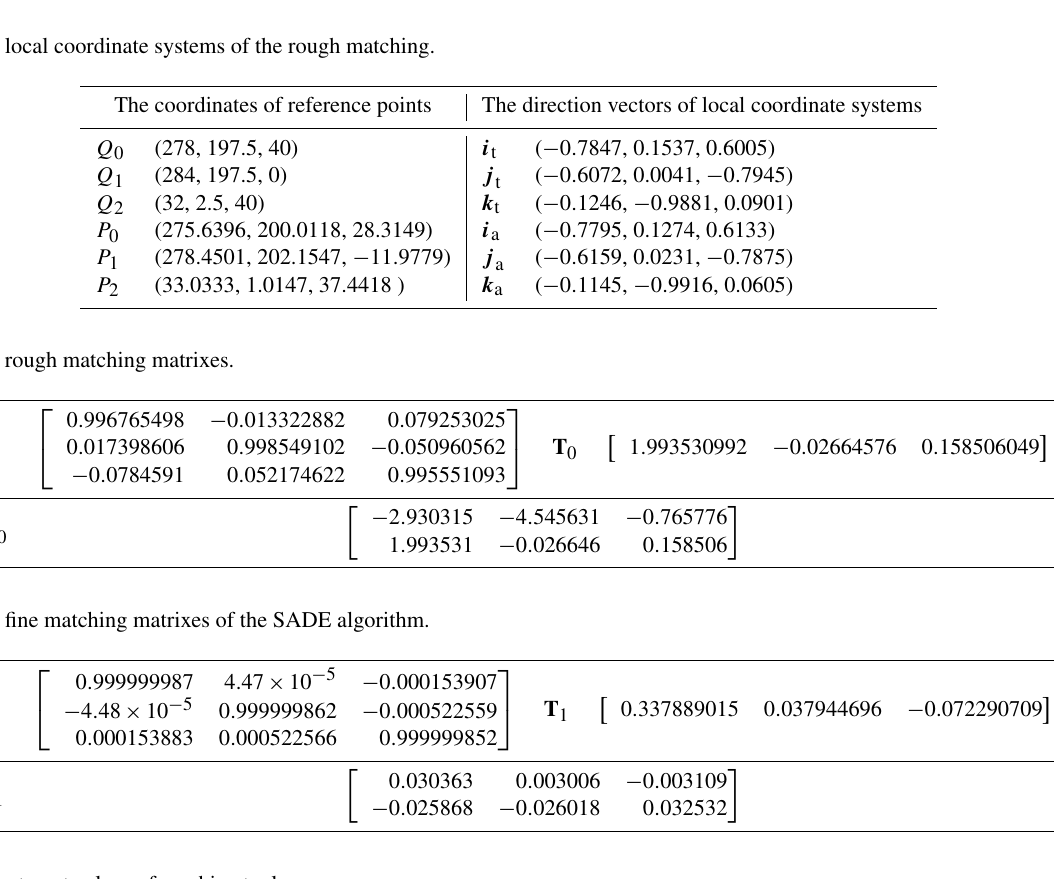
Table 4. Adjustment values of machine